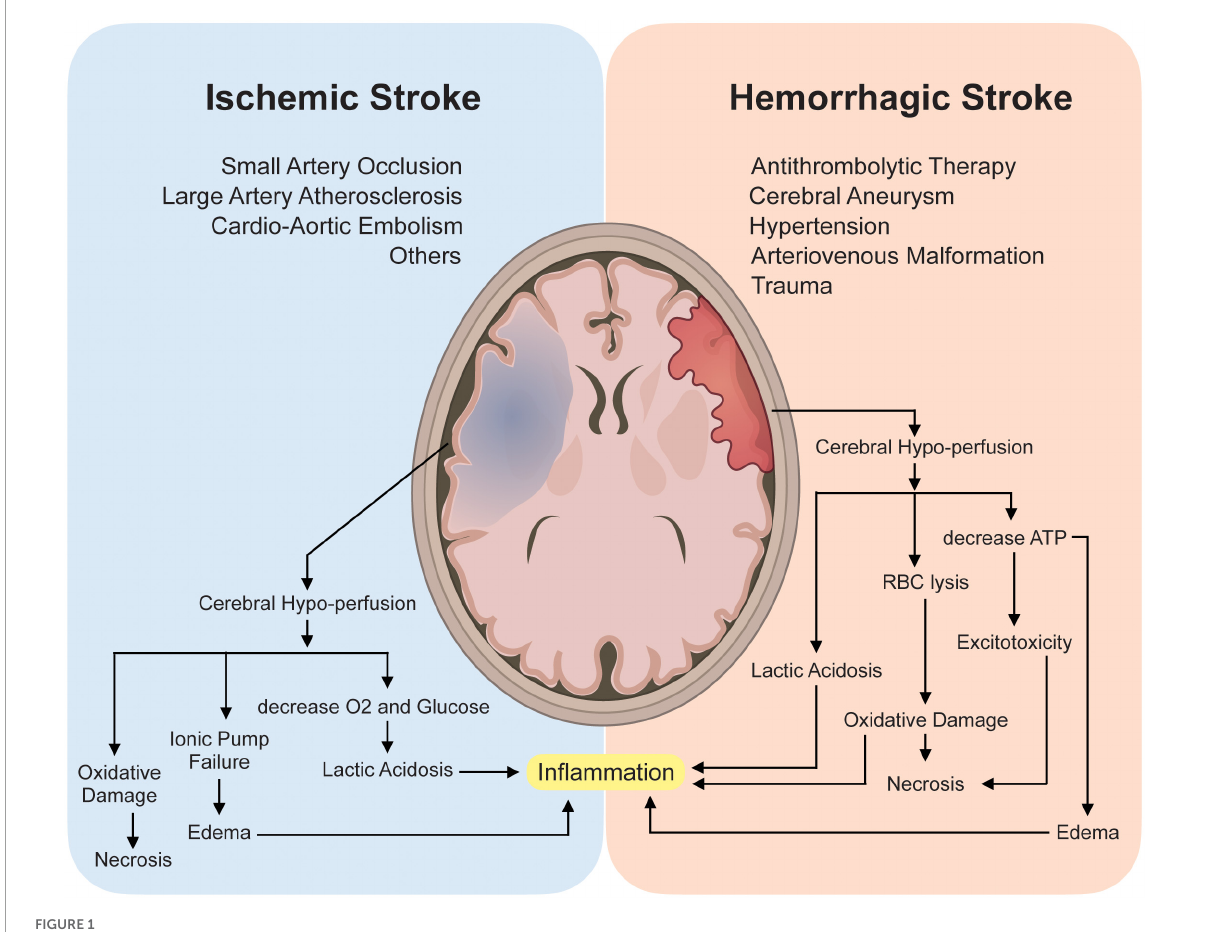
FIGURE1 Pathophysiology and Mechanism involved in Ischemic and Hemorrhagic stroke. Briefly, mechanisms involved in both ischemic and hemorrhagic stroke involve cerebral hypo-perfusion leading to oxygen (O 2 ) deprivation causing an increase in anaerobic metabolism and eventually lactic acidosis which sequentially causes astrocyte demise and an increase in neuroinflammatory cytokines thus promoting neuroinflammation. Subsequently, cerebral hypo-perfusion can also cause malfunction of the ionic pump causing potassium ions (K + ) efflux, sodium and calcium (Na + and Ca 2 + respectively) influx into the neuronal cells and adenosine triphosphate (ATP) depletion causing excitotoxicity, edema, and eventually led to necrosis. Red blood cell lysis can further cause oxidative damage which further supports